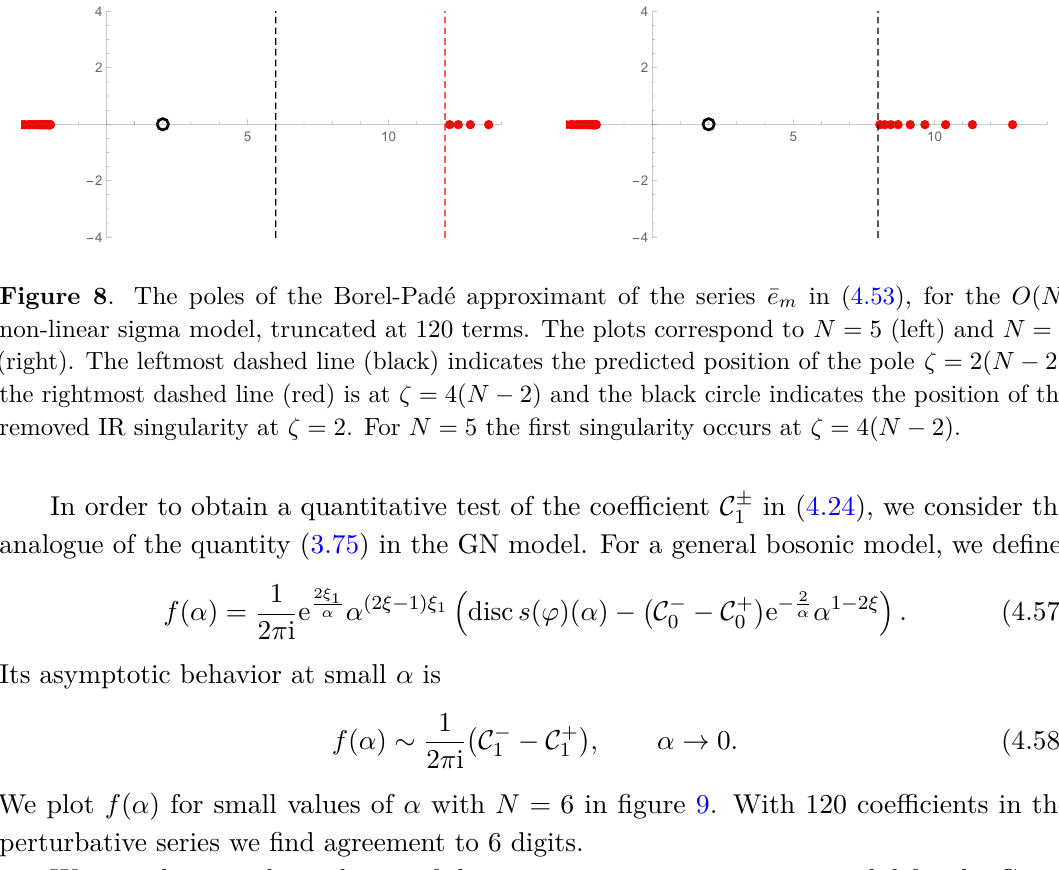
Table 1 . Leading behavior of the discontinuity of the Borel sum, as given by (4.54), for the non-linear O ( N ) sigma model, 5 ≤ N ≤ 12 . We compute the leading coefficient directly from the Borel sum of the perturbative series (second column) and compare it to the value extracted from the trans-series coefficient (third column).